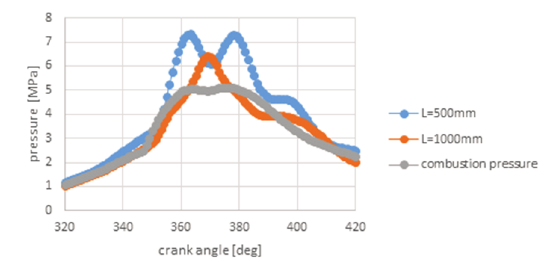
Fig. 8. Pressure at MP5 of the cylinder at different lengths of the indicator